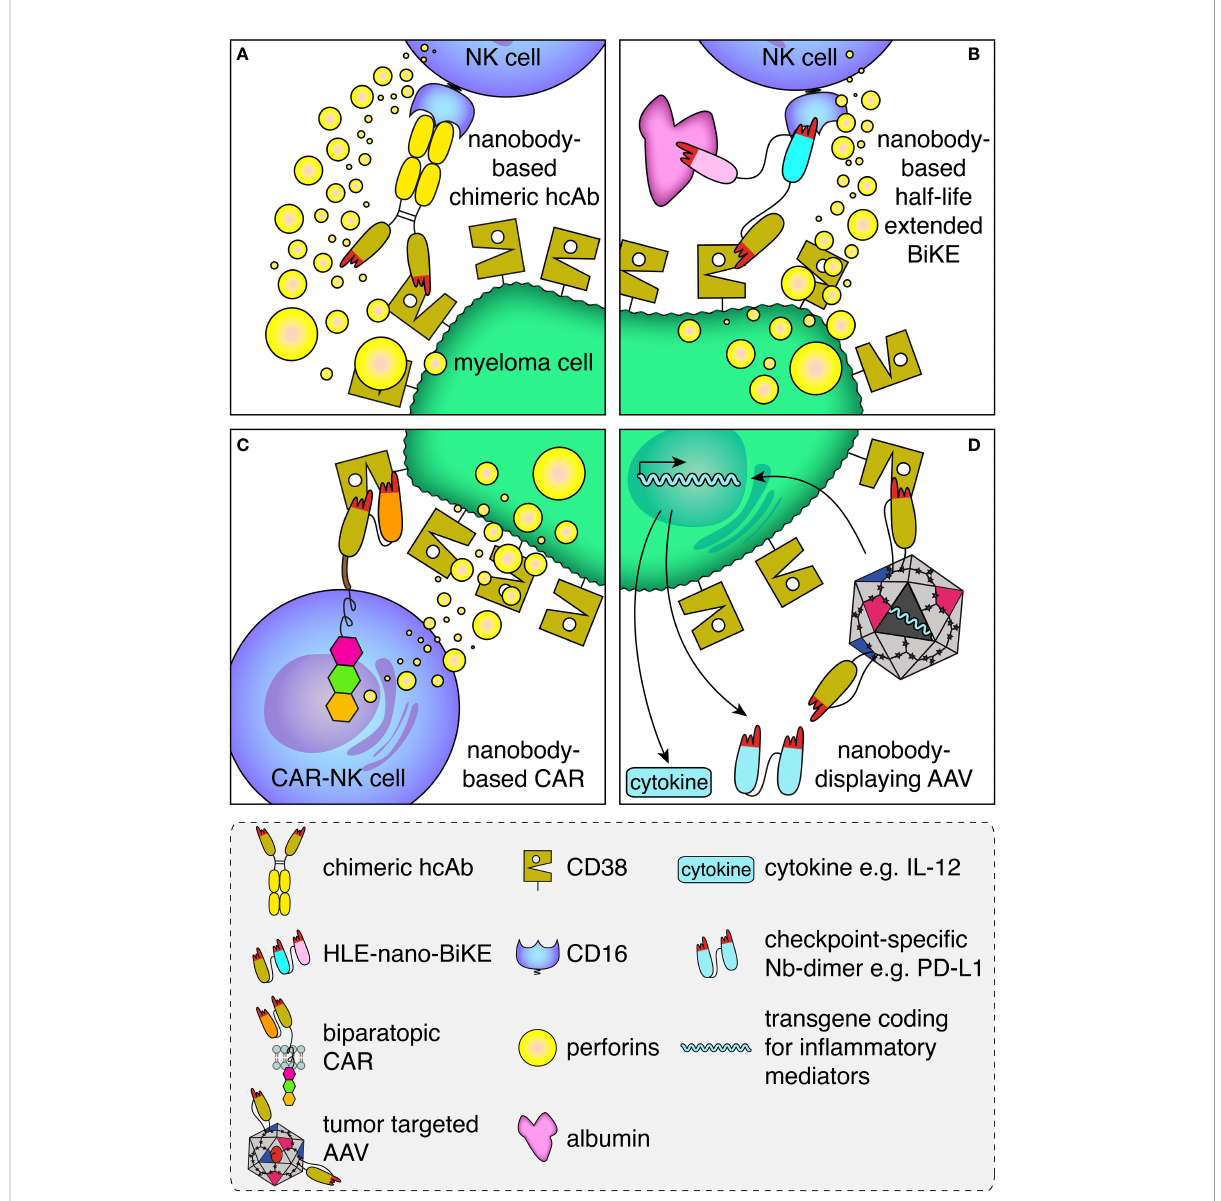
FIGURE 2 Schematic illustration of the mode of action of the CD38-speci fi c nanobody-based hcAbs, BiKEs, CARs and nanobody-displaying AAVs. (A) Antibody-dependent cellular cytotoxicity (ADCC) by an NK cell against a myeloma cell is mediated by a CD38-speci fi c nanobody-based heavy chain antibody. A nanobody-based CD38-speci fi c heavy chain antibody (hcAb) bound to a tumor-antigen (CD38, olive) on the plasma membrane of a multiple myeloma cell is recognized by an Fc-receptor (CD16, blue) of an NK cell. Cross-linking of CD16 on the NK cell induces the release of perforins, which form pores and kill the myeloma cell. (B) A half-life extended (HLE)-nano-BIKE crosslinks CD38 on the tumor cell and CD16 on the NK cell, causing release of perforins and killing of the myeloma cell. A third, albumin-speci fi c nanobody (magenta) binds to albumin in the plasma and thereby extends the half-life of the construct by slowing renal fi ltration. (C) An NK cell transduced with a biparatopic nanobody-based chimeric antigen receptor (CAR) binds to CD38. Cross-linking of multiple nano-CARs on the NK cell surface triggers the release of perforins and lysis of the myeloma cell. (D) A membrane protein-speci fi c CD38-speci fi c nanobody inserted in the capsid of an AAV mediates speci fi c transduction of tumor cells expressing the cognate target. Expression of the transgene encoding a pro-in fl ammatory cytokine (e.g. IL-12) and/or a checkpoint blocking nanobody dimer (e.g. a -PDL-1) helps to convert an immunosuppressive into an in fl ammatory tumor